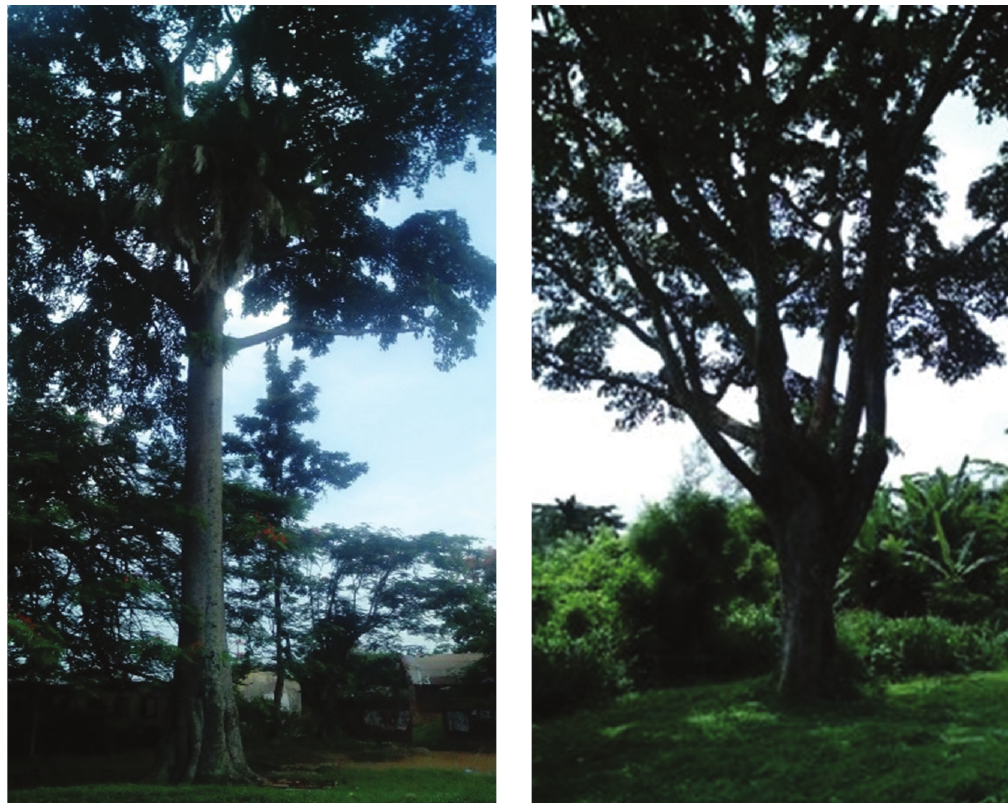
FIGURE 1. Female (left) and male (right) M. excelsa in the University of